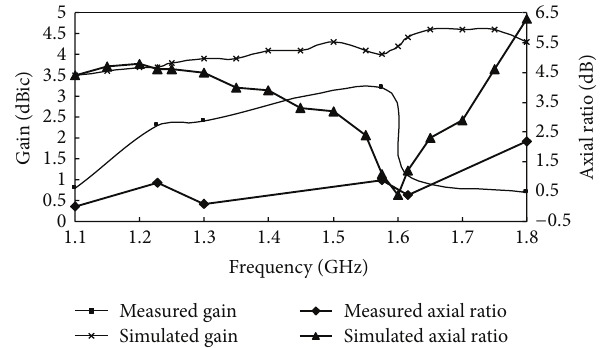
Figure 13: Comparison between measured and simulated results of gain and axial